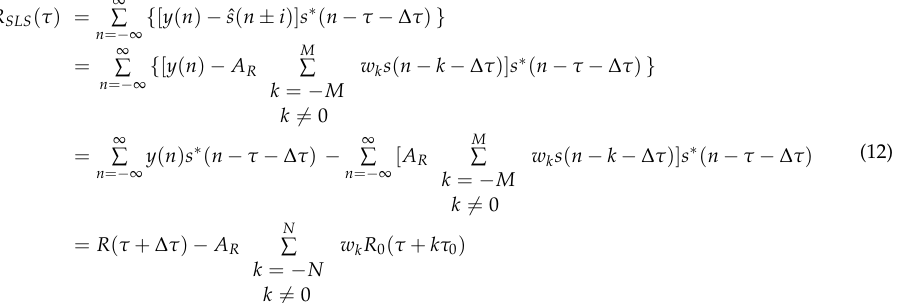
Figure 9. Influence of correlation function at different interference frequencies.